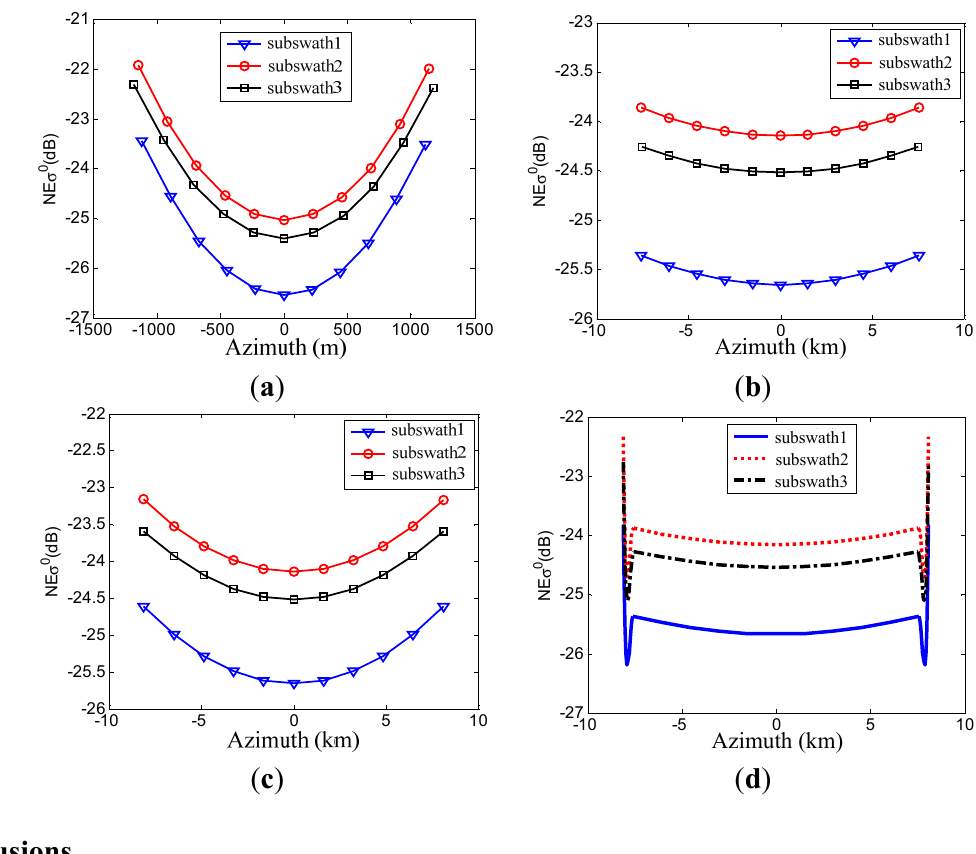
Figure 11. Noise-equivalent sigma zero (NESZ) of different imaging